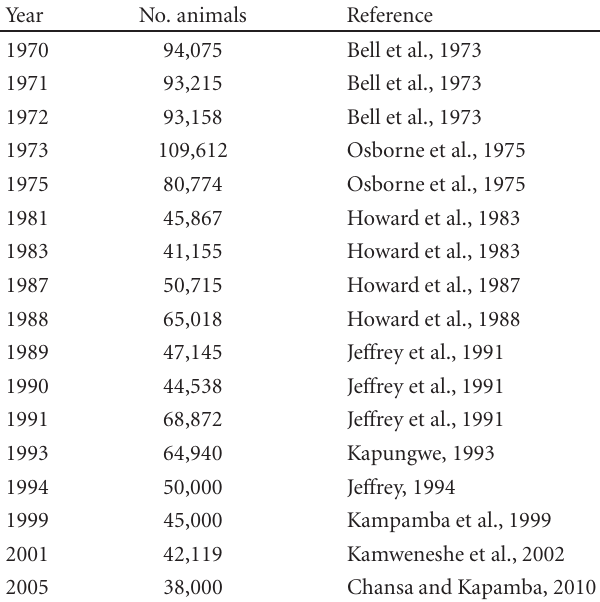
Table 1: Population of the Kafue lechwe ( Kobus leche kafuensis ) between 1970 and